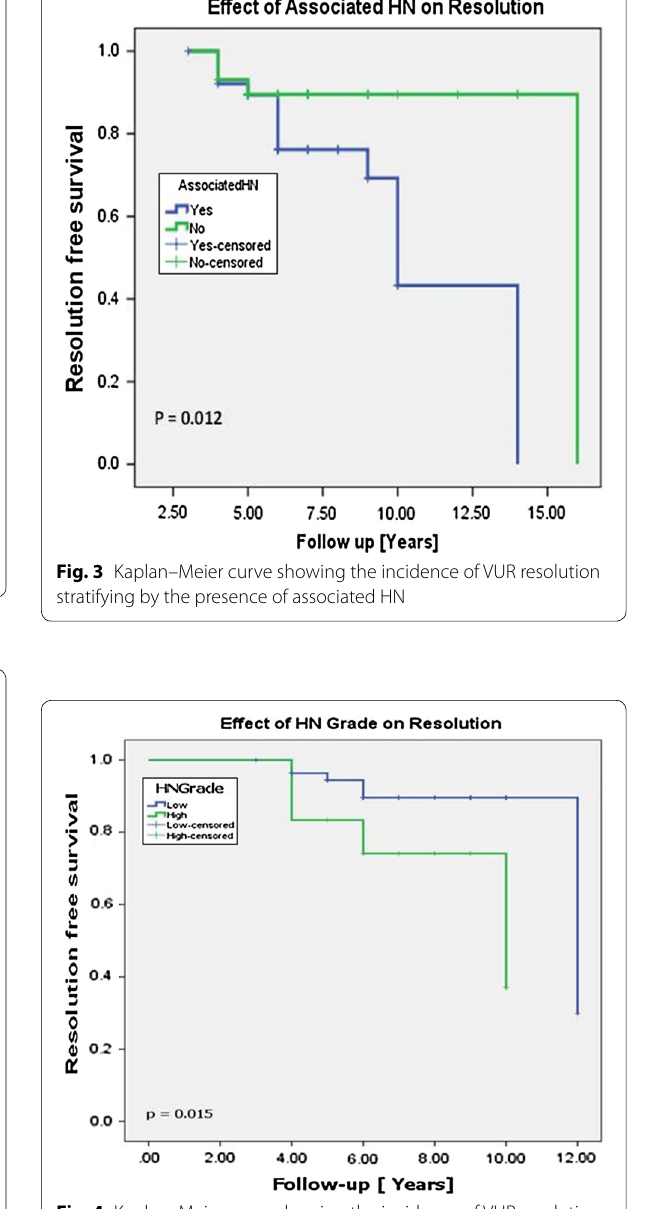
Fig. 4 Kaplan–Meier curve showing the incidence of VUR resolution stratifying by the grade of associated